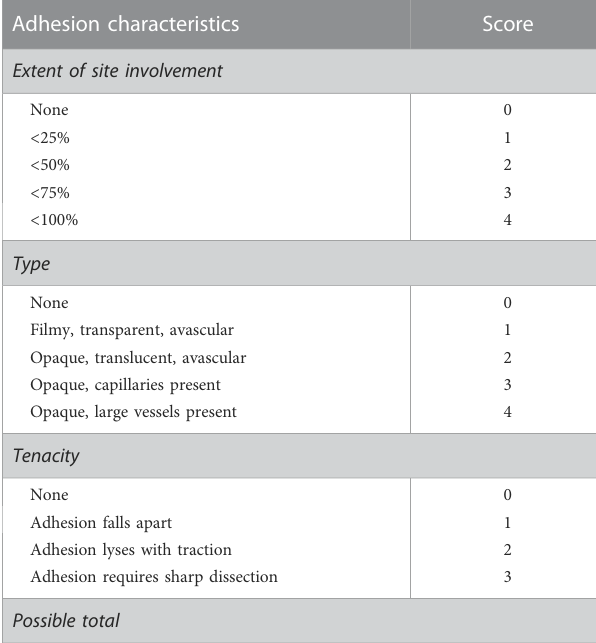
TABLE 1 The surgical membrane study group